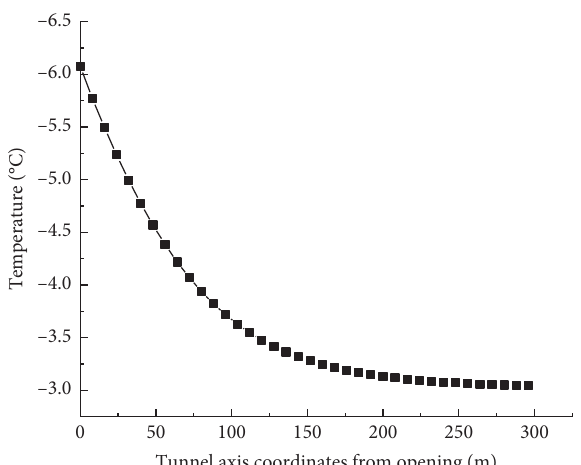
Figure 33: Longitudinal distribution of the average temperature in the